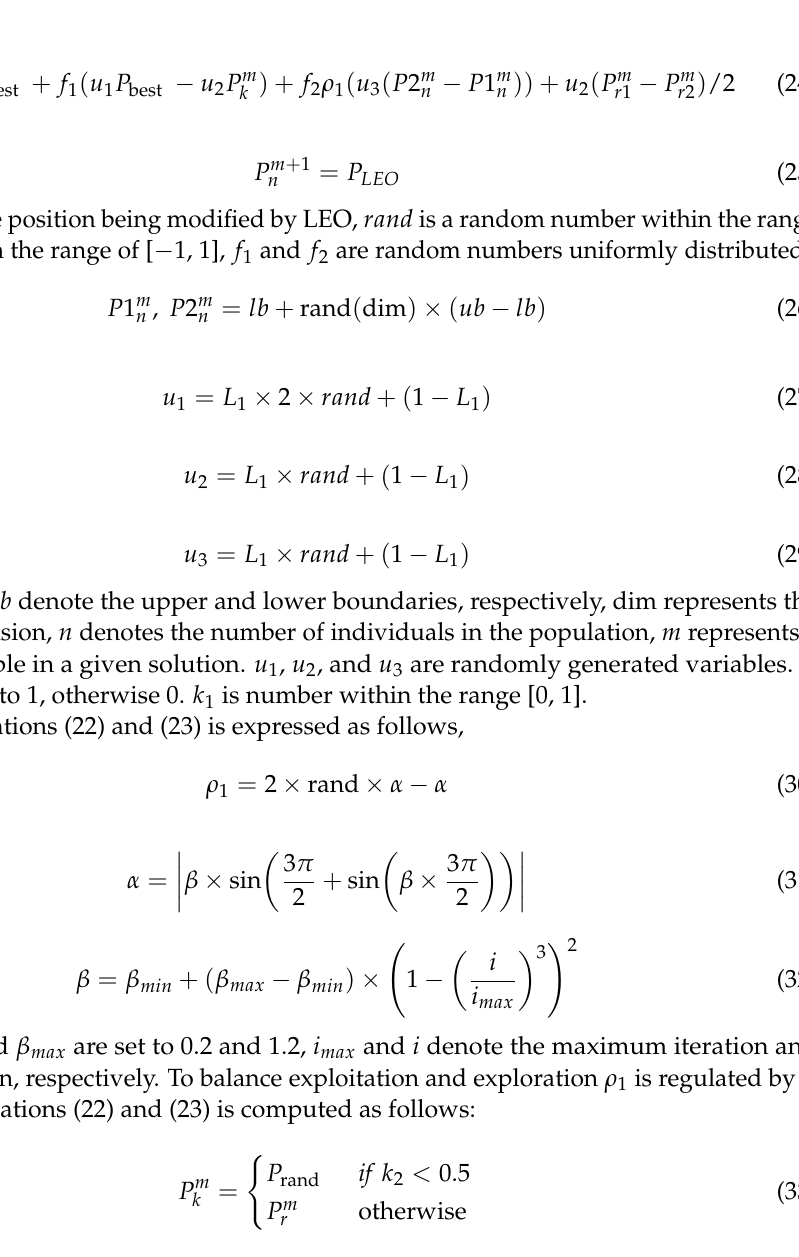
Algorithm 2 and Figure 3 show the pseudocode and the flowchart of GSLEO-AEFA, respectively. The method begins with the population initialization using SRL and then uses GM to further increase the population diversity. The LEO is placed afterwards to improve the position of each